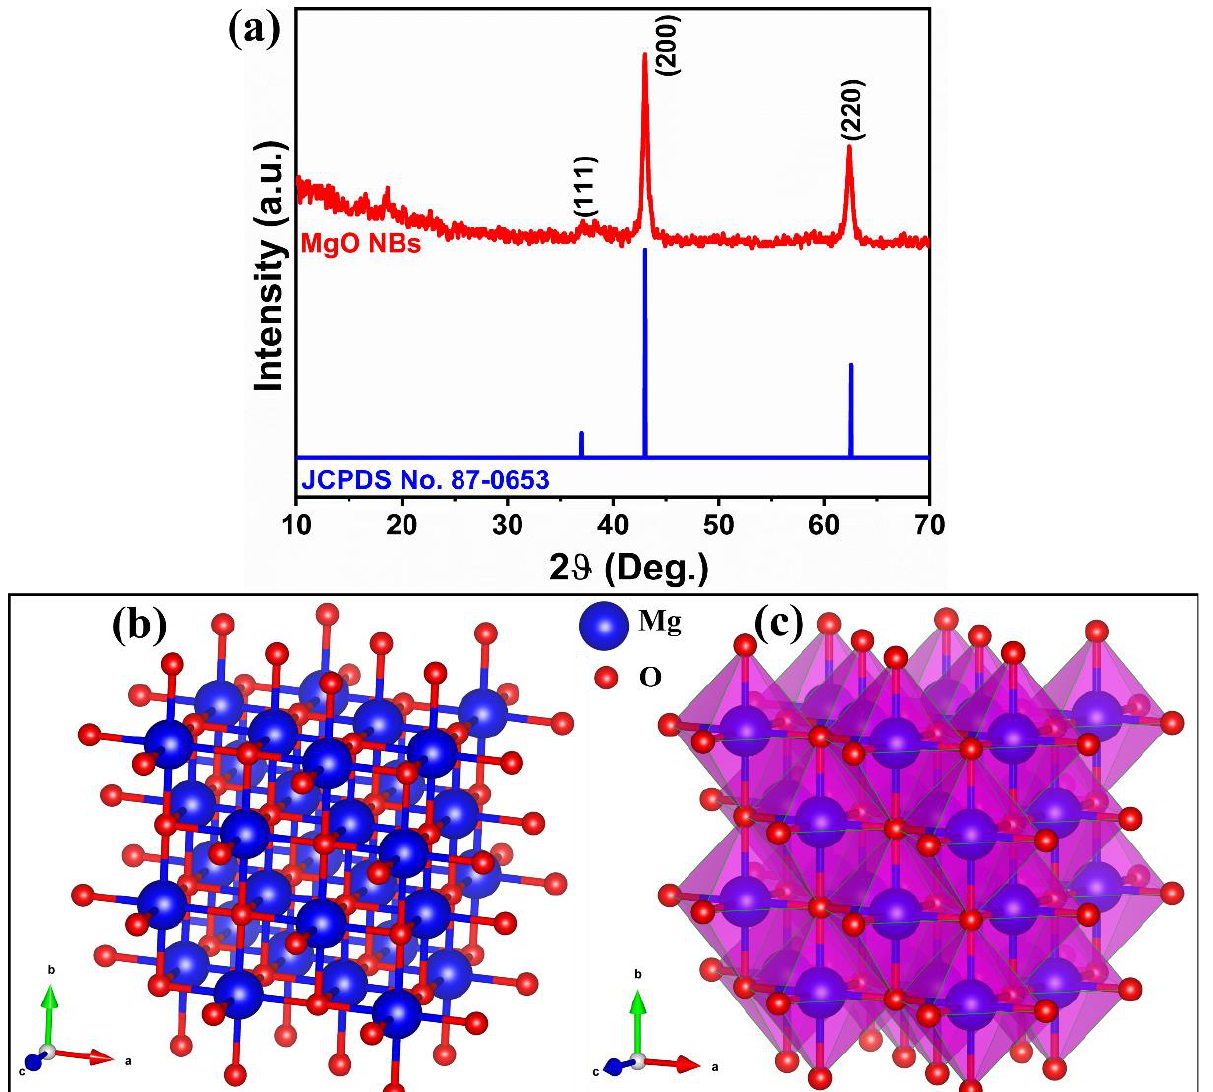
Figure 1. ( a ) Powder XRD pattern of MgO NBs. The cubic crystal structure of MgO drawn by Vesta software (Version 3.4.5); ( b ) Ball-and-stick model and ( c ) Polyhedral model. Unit cell lattice parameters: crystal system — Cubic, space group — Fm-3m, distances a = b = c = 4.21700, along with axes (for Mg, x = 0, y = 0 and z = 0 and for O, x = 0.500000, y = 0.500000 and z = 0.500000), and angles α = β = γ = 90°.